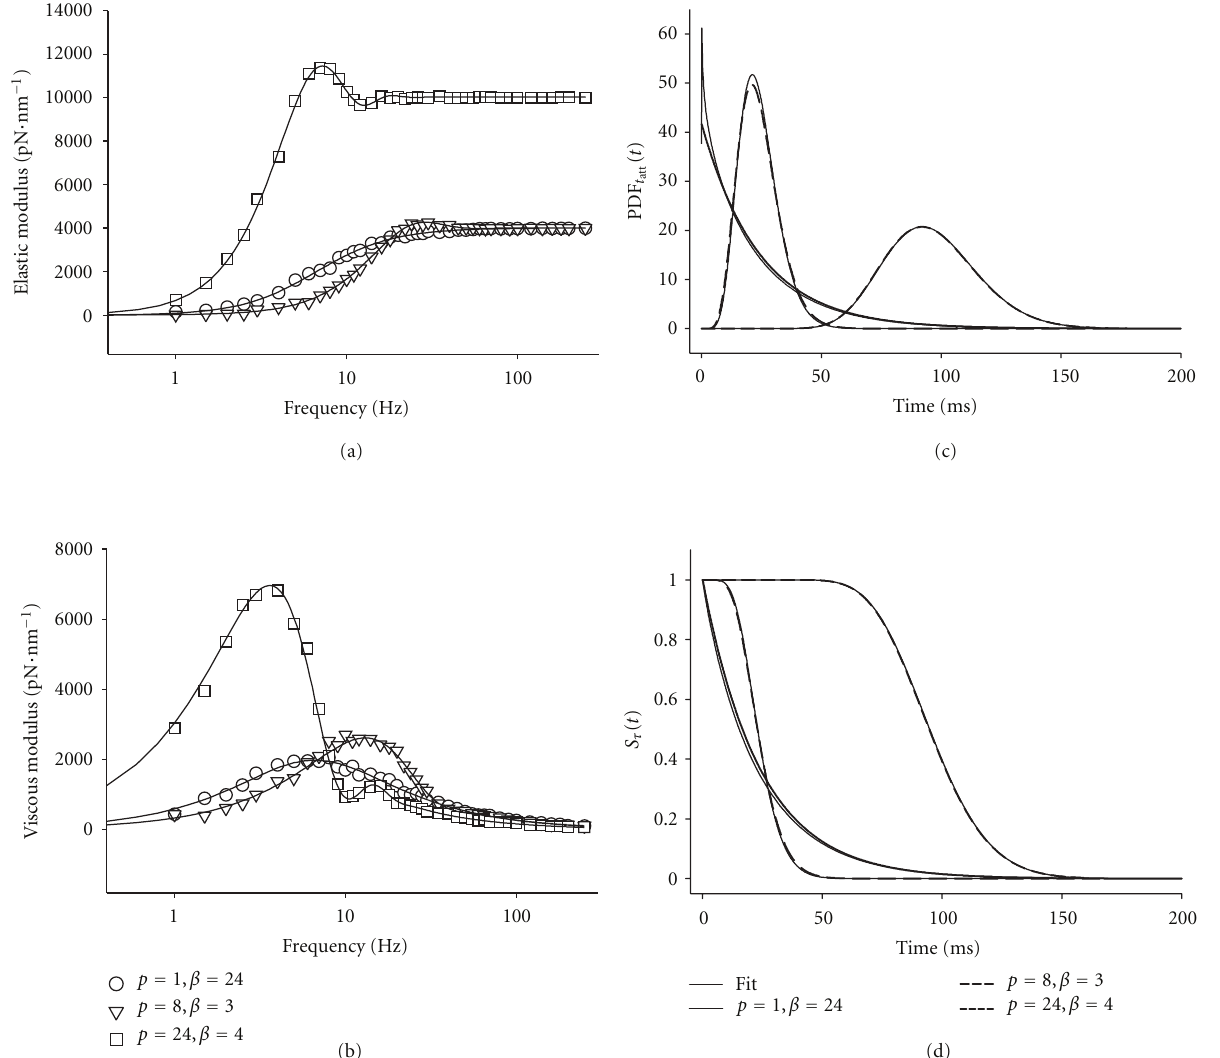
Figure 4: Examples of results from computer simulations. (a, b) The elastic and viscous moduli are plotted against frequency for three p and β pairs. Nonlinear least-squares fitting of (15) to the data produced a good fit shown as the line for each pair of p and β . (c) The parameters estimated from fitting (15) to the simulated data provided a comparison between the PDF t distribution predicted from the fits. In this case, the predicted gamma distributions are nearly indistinguishable from the original PDF t